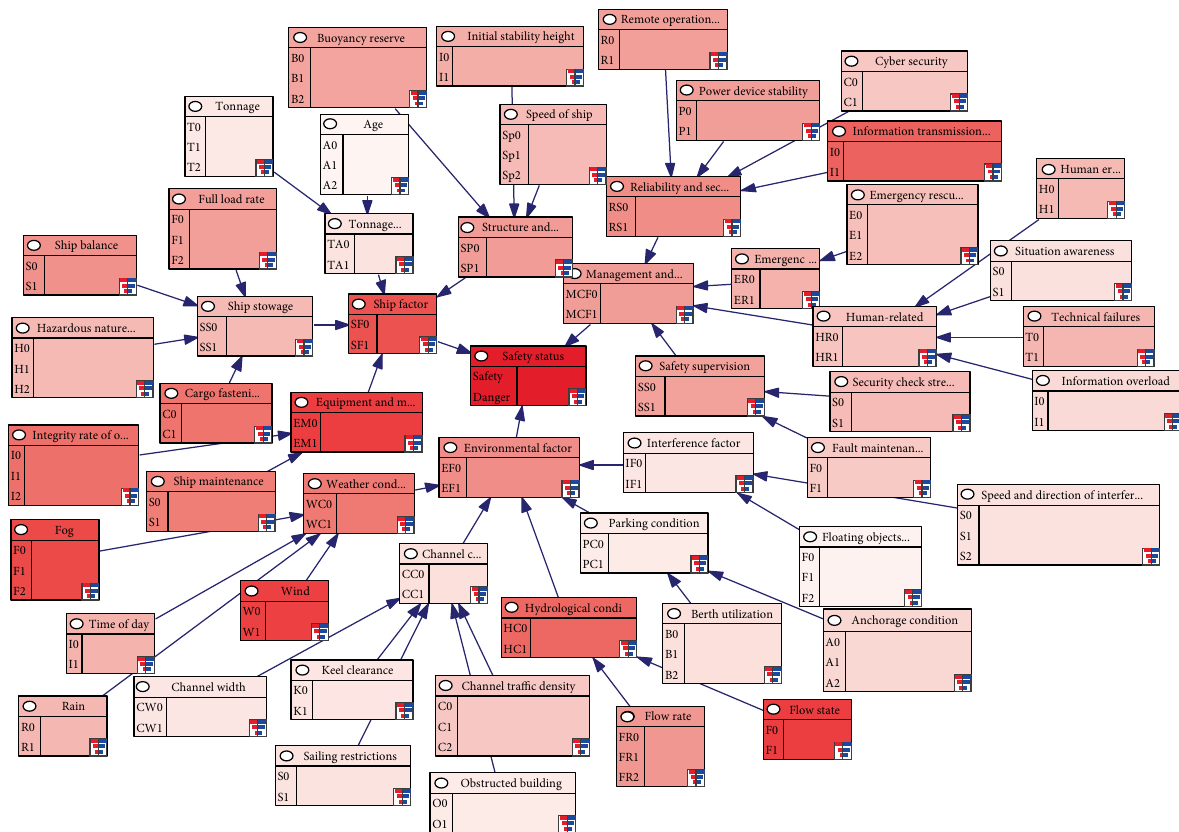
Figure 6: Sensitivity analysis of the Bayesian